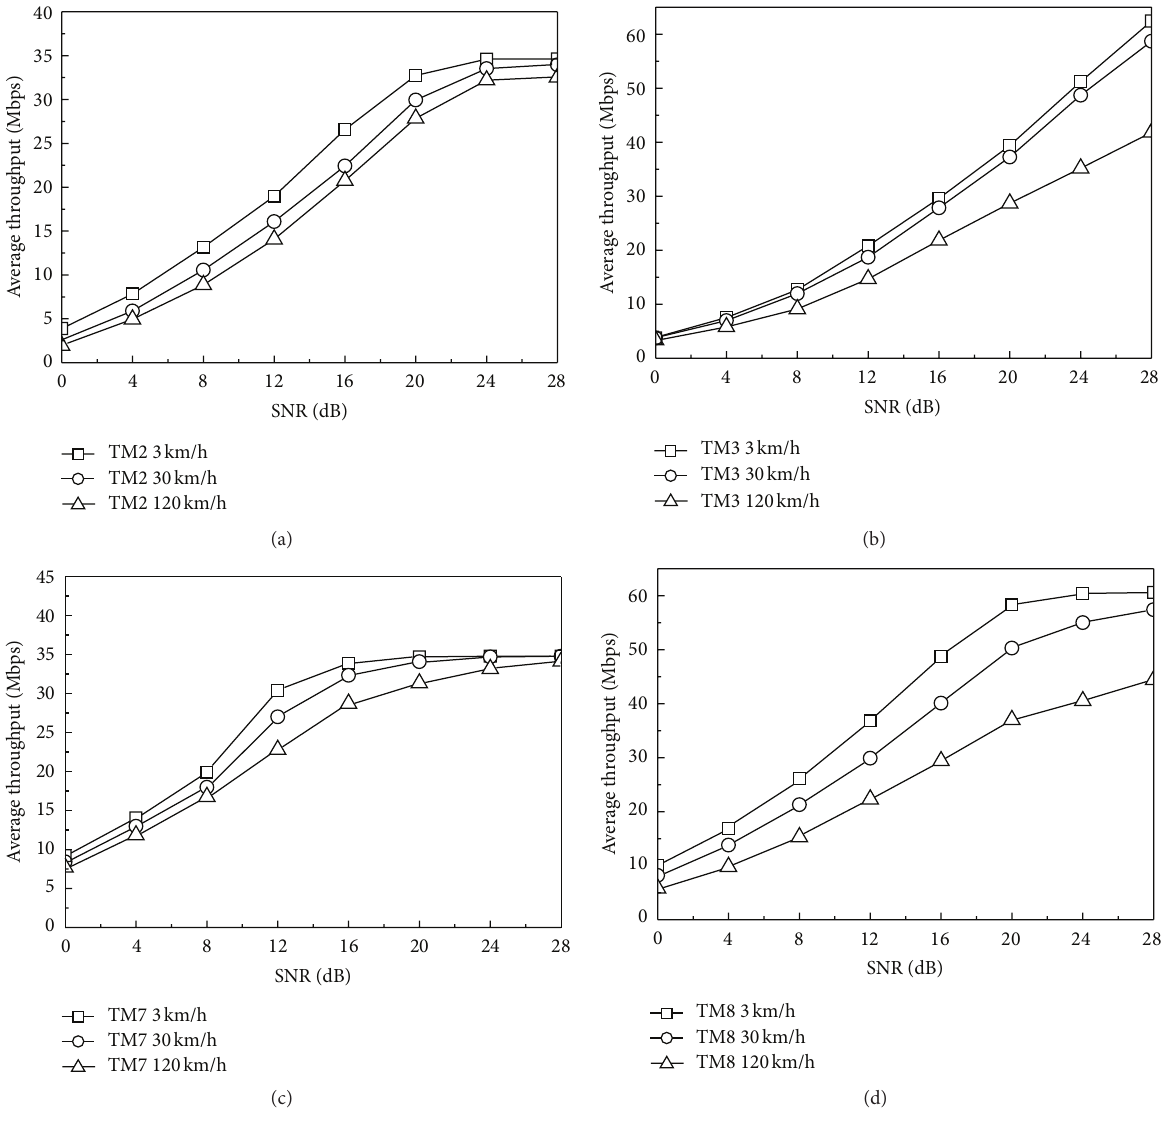
Figure 1: The downlink average throughput for IMT-A